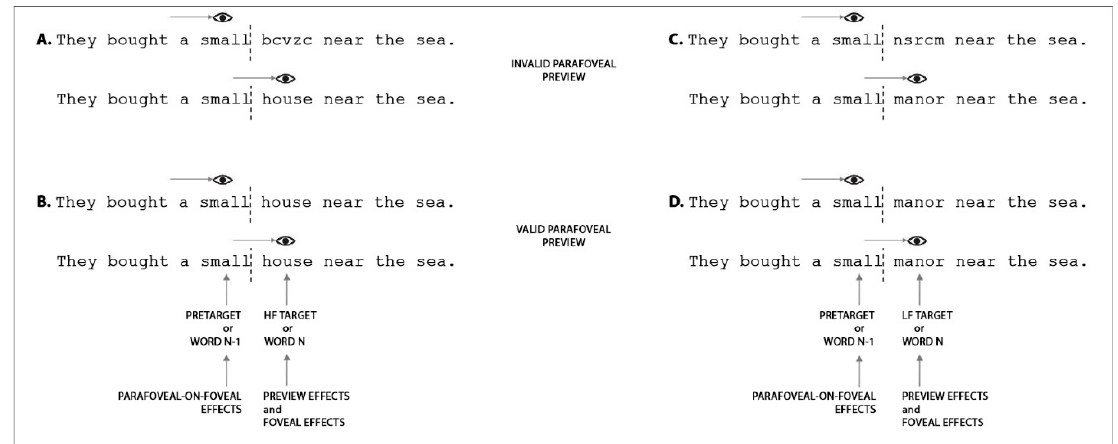
Figure 1. Illustration of example stimuli and investigated e ff ects. The image shows example sentences presented according to the boundary paradigm [28]. An invisible boundary is placed at the end of the pretarget word (i.e., ‘small’). When the eyes fixate the pretarget word, a preview is displayed in the parafovea (i.e., ‘bcvzc’, ‘house’, ‘nsrcm’, ‘manor’). When the eyes cross the invisible boundary, the target word is displayed (i.e., ‘house’, ‘house’, ‘manor’, ‘manor’). Panels A and B di ff er from panels C and B in the frequency with which the target words ‘house’ and ‘manor’ occur in the English language, such that ‘house’ is a high frequency (HF) word, ‘manor’ is a low frequency (LF) word. In addition, panels A and C di ff er from panels B and D as the preview stimulus is an invalid preview in the first two panels, but a valid preview for the other two panels. That is, in panels A and C, a string of random letters is presented in the parafovea, and this string does not share many features with the target word (i.e., bcvzc’–‘house’, ‘nsrcm’–‘manor’). Instead, in panels B and D, preview and target words